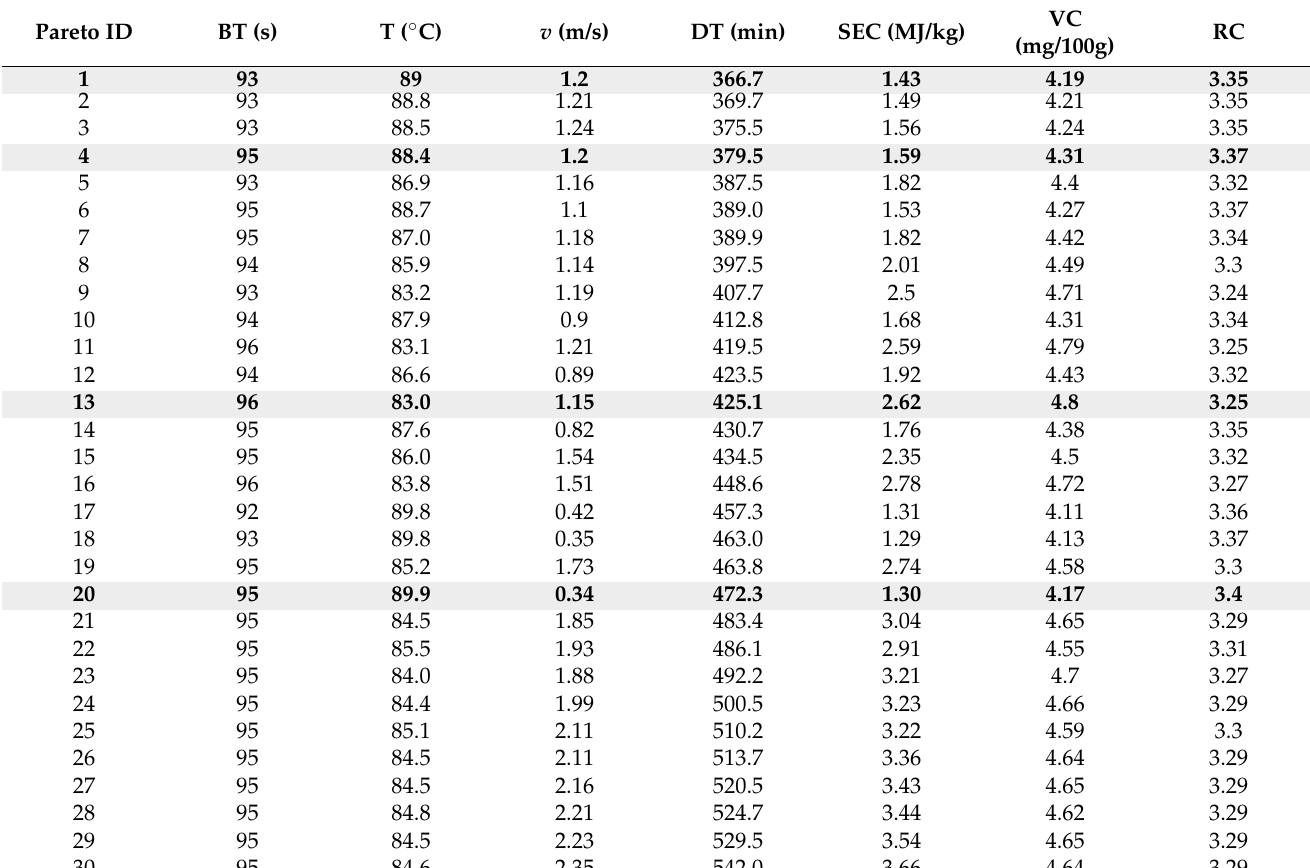
Table 4. Pareto front optimal solutions for HHAIB and HAIR processing of